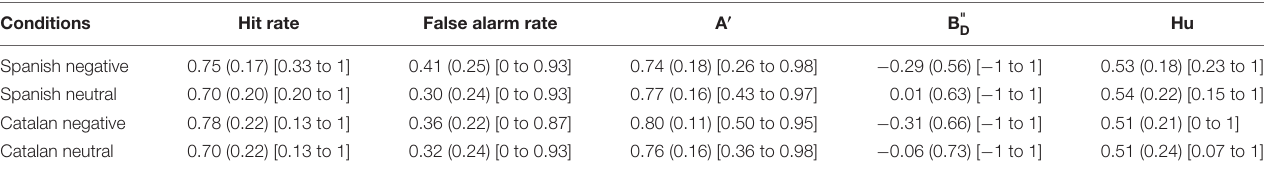
TABLE 2 | Mean, standard deviation (in parentheses), minimum and maximum values (in square brackets) of the dependent variables across experimental conditions in Experiment 1. Conditions